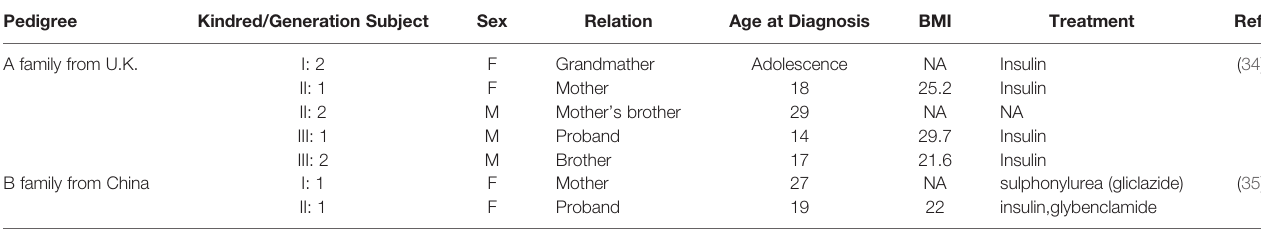
TABLE 2 | The clinical characteristics of two R54X variants from different countries. Pedigree Kindred/Generation Subject Sex Relation Age at Diagnosis BMI Treatment Ref